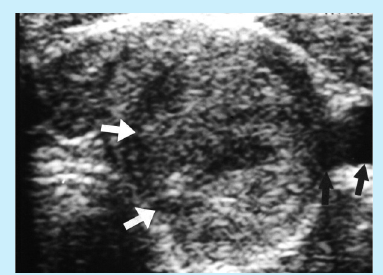
Fig. 1. Ultrasound demonstrates the inhomo- geneous left thyroid lobe mass (white arrows) and the adjacent carotid and jugular vessels (black arrows).